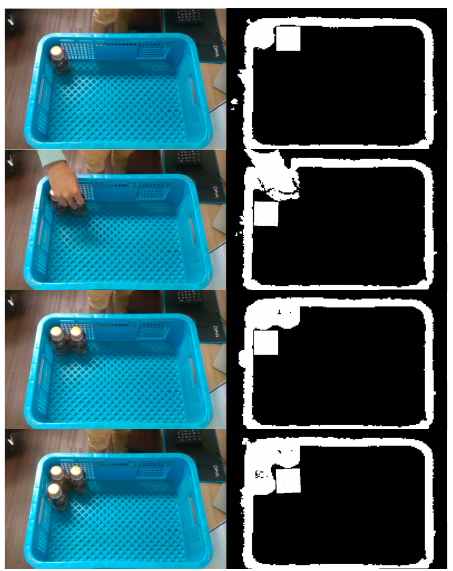
Figure 7. The snap shots of the actual object-packing